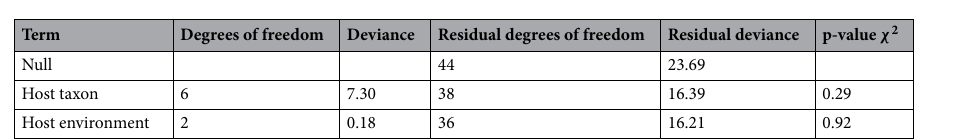
∼ Host Taxon + Host Environment) fitted for Callithrix gut